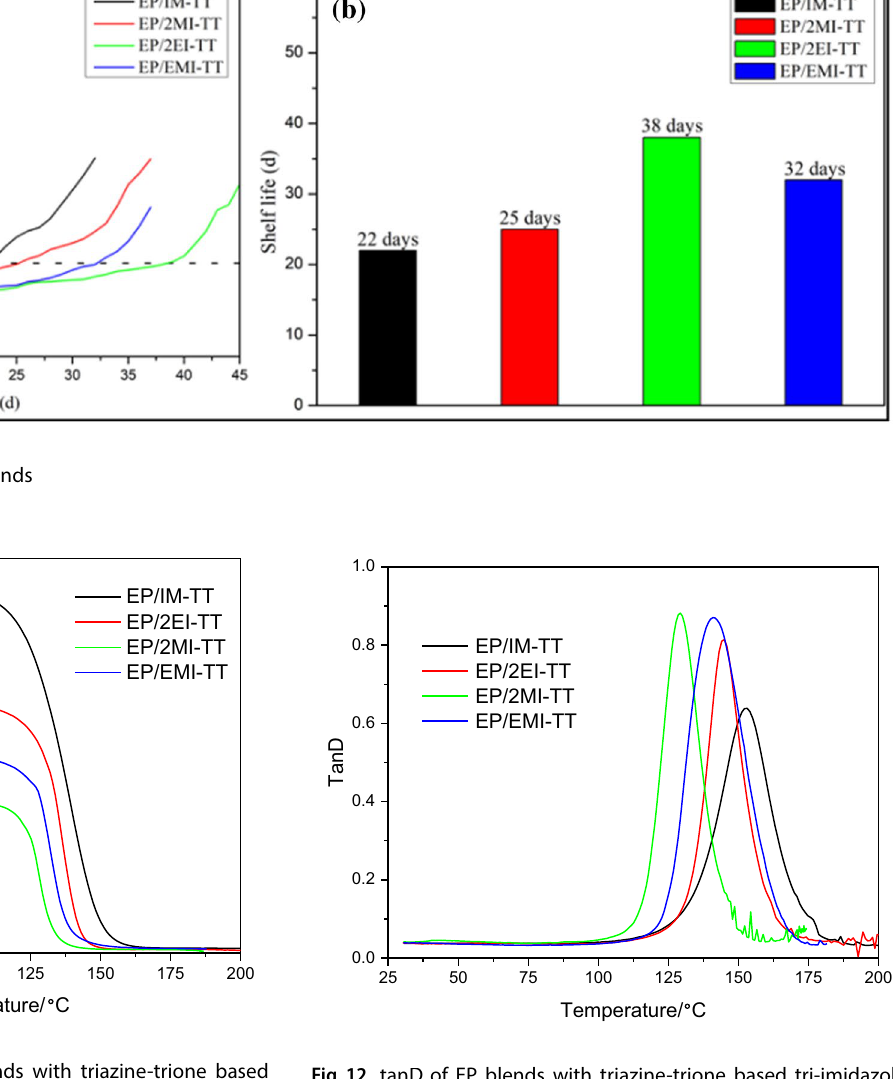
Fig. 12 tanD of EP blends with triazine-trione based tri-imidazole